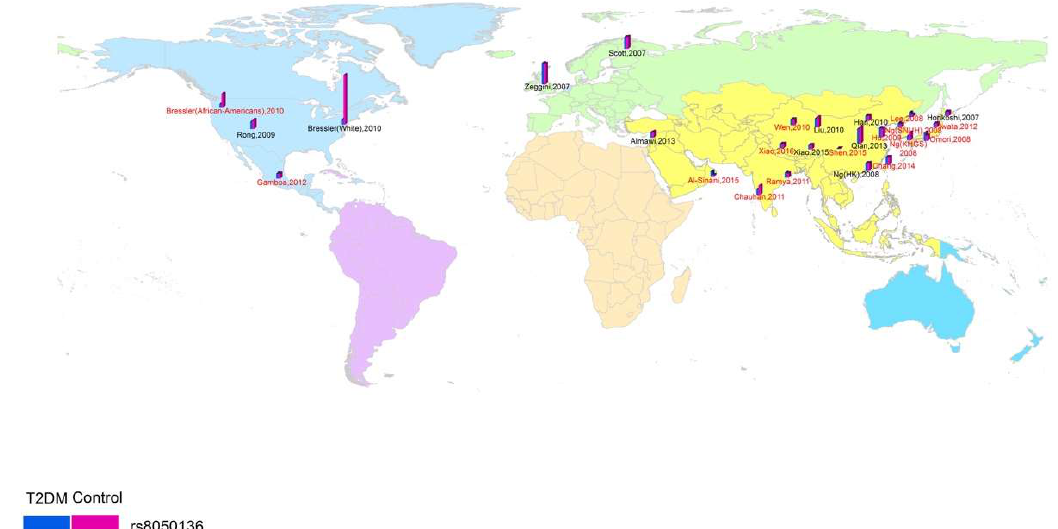
Figure 3. The stratified analysis results of rs8050136 grouped by region: ( a ) without; and ( b ) with adjustment for BMI.